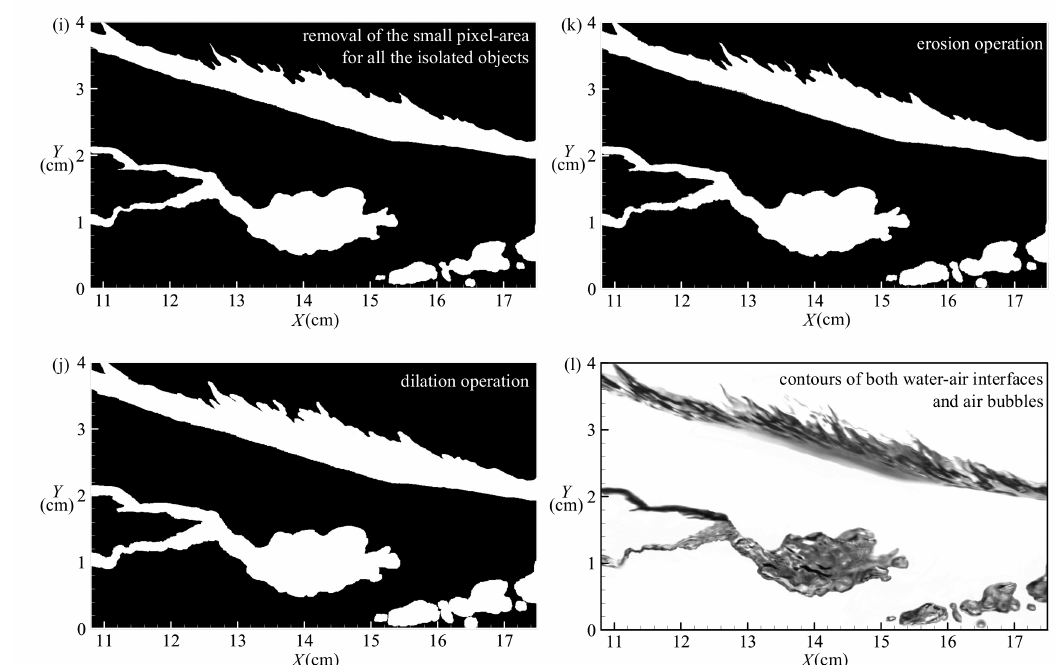
Figure 6. ( a , b ) The instantaneous magnified image exhibiting relatively dark, noise-like blurred background appearing outside the DOF at t = − 0.15866 s/ − 0.15833 s; ( c , d ) The smoothed image corresponding to (a,b); ( e ) The difference image obtained from (c, d), along with the color code representing the difference in gray-level; ( f ) The binary image acquired; ( g ) The image procured by closing operation; ( h ) The image achieved by filling operation; ( i ) The image obtained by removal of the small pixel-area for all the isolated objects; ( j ) The image obtained by dilation operation; ( k ) The image given by erosion operation; ( l ) The processed image with clear gray-level contours of both water–air interfaces and air bubbles (i.e., the noise-like blurred background has been effectively